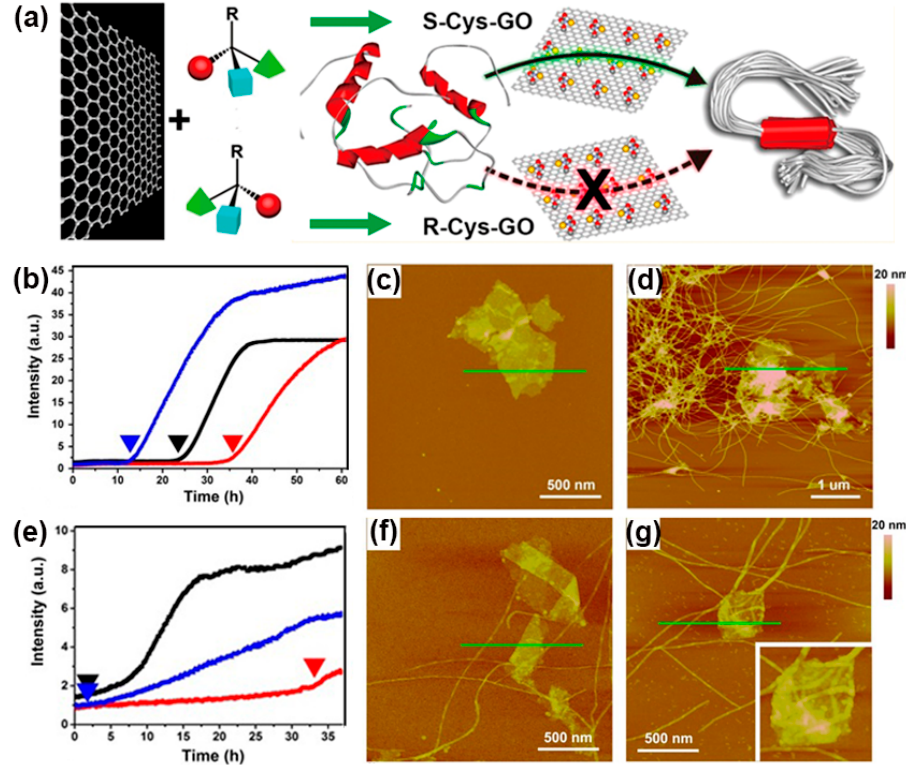
Figure 6. ( a ) Illustration of the R-Cys-graphene oxide (GO) and S-Cys-GO films and their influence on A β (1–40) aggregation. Time-dependent fluorescence intensity changes: ( b ) R- (red) and S-Cys-GO (blue) added at the beginning of incubation; ( e ) R- (red) and S-Cys-GO (blue) added after 10 h of incubation. Black curves are all the control experiment with only A β (1–40) peptides. All the experiments were performed in the working solutions (100 μ L) containing 25 μ M A β (1–40) peptides, 25 μ M ThT in phosphate buffer solution (50 mM, pH 7.4), and then 100 μ L aqueous solution of various chiral GO samples (0.15 mg · mL -1 ) were added to the pre-prepared solutions, respectively. AFM images of R(S)-Cys-GO after incubation in A β (1–40) solutions (25 µ M): ( c , f ) R-Cys-GO; ( d , g ) S-Cys-GO; and ( c , d ) R(S)-Cys-GO were added at the beginning of incubation; and ( f , g ) GO samples were added after 10 h of incubation at 37 ◦ C [41]. ( a – g ) Adapted with permission. Copyright 2014, ACS. In 2014, Sun et al. reported another appealing work in this